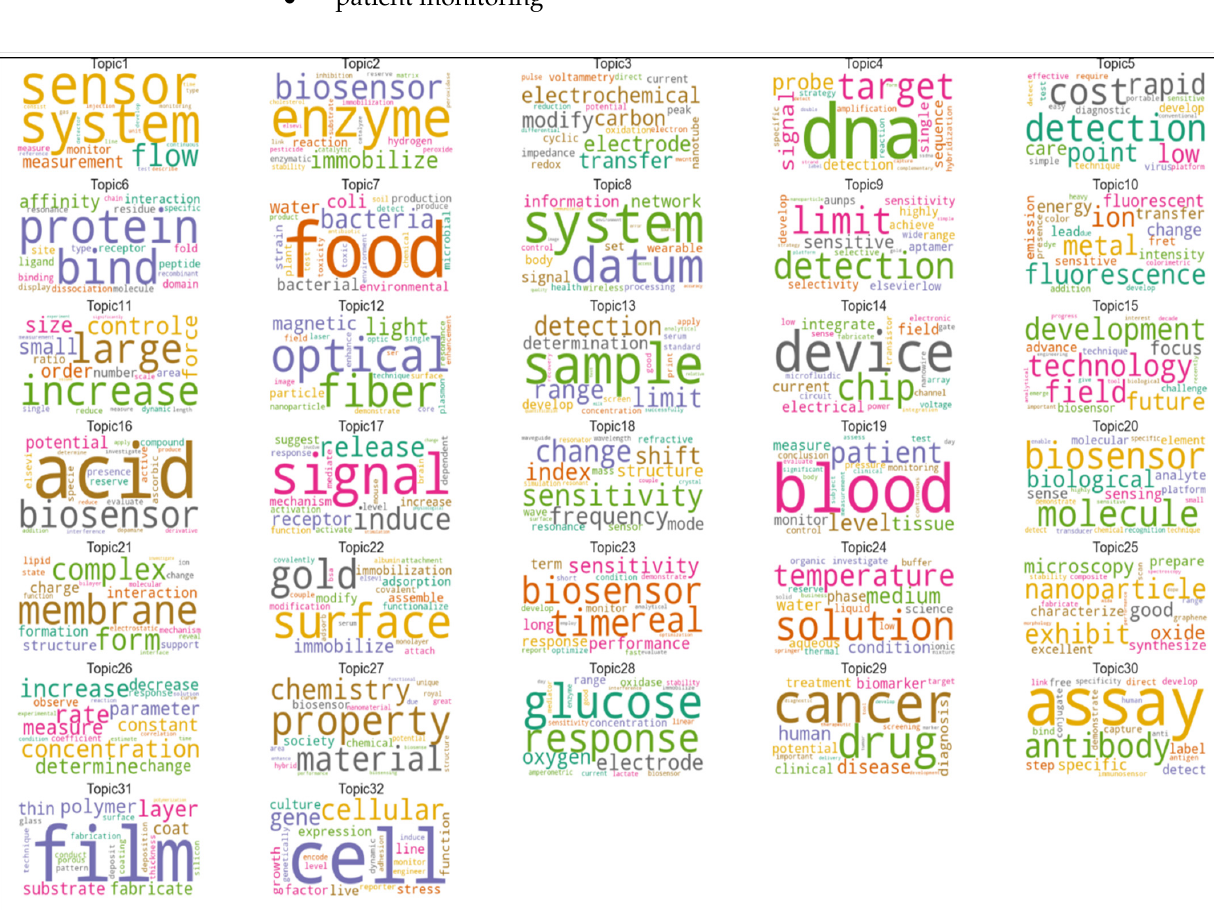
Figure 9. Cloud words in documents of biosensors.